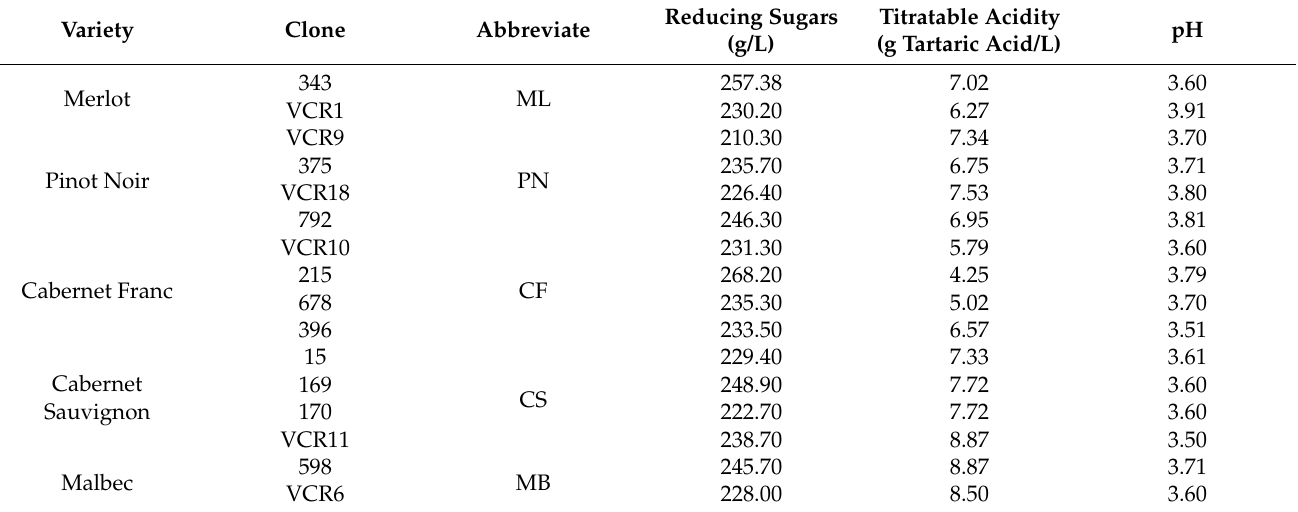
Table 1. Standard enological parameters of grape